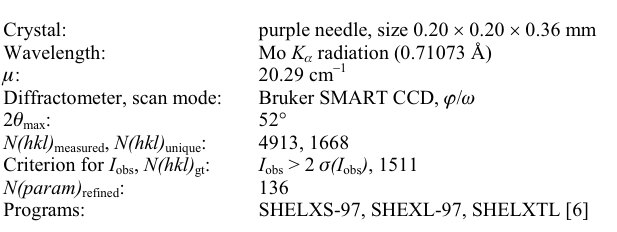
Table 1. Data collection and handling.